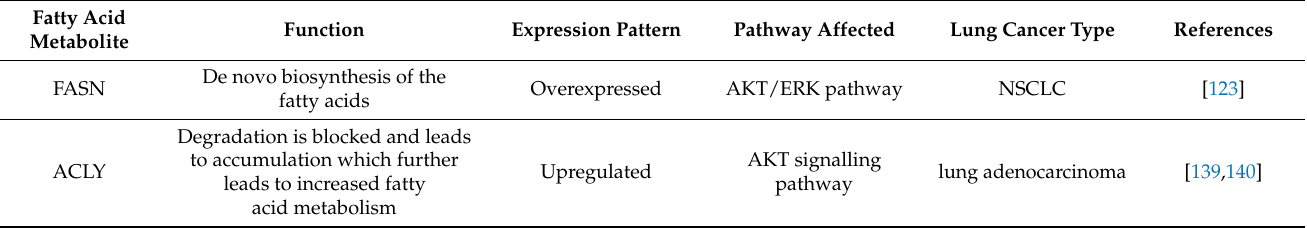
Table 1. Expression patterns and functions of fatty acid metabolites involved in the different types of lung cancer and its